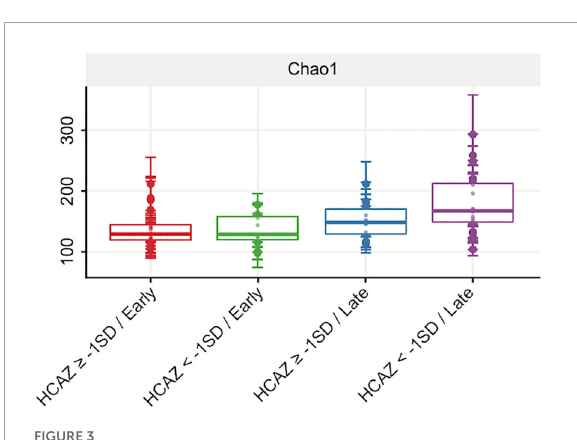
FIGURE3 Human milk alpha-diversity (richness) at early and late lactation stages. Comparing head-circumference-for-age-z-score HCAZ ≥ − 1 SD (early: n = 18; late: n = 14) and HCAZ < − 1 SD (early: n = 11; late: n = 19). Alpha diversity Chao1 index was significantly different ( t -test, p = 0.05) between HCAZ ≥ − 1 SD and HCAZ < − 1 SD at late